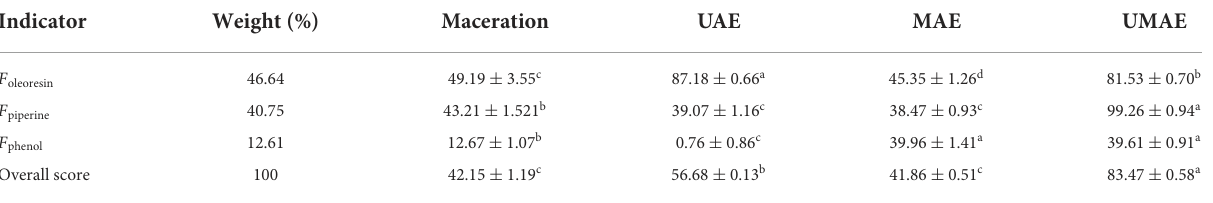
TABLE 1 Comparison of factors and the overall score of oleoresins extracted by four kinds of methods. Indicator Weight (%)